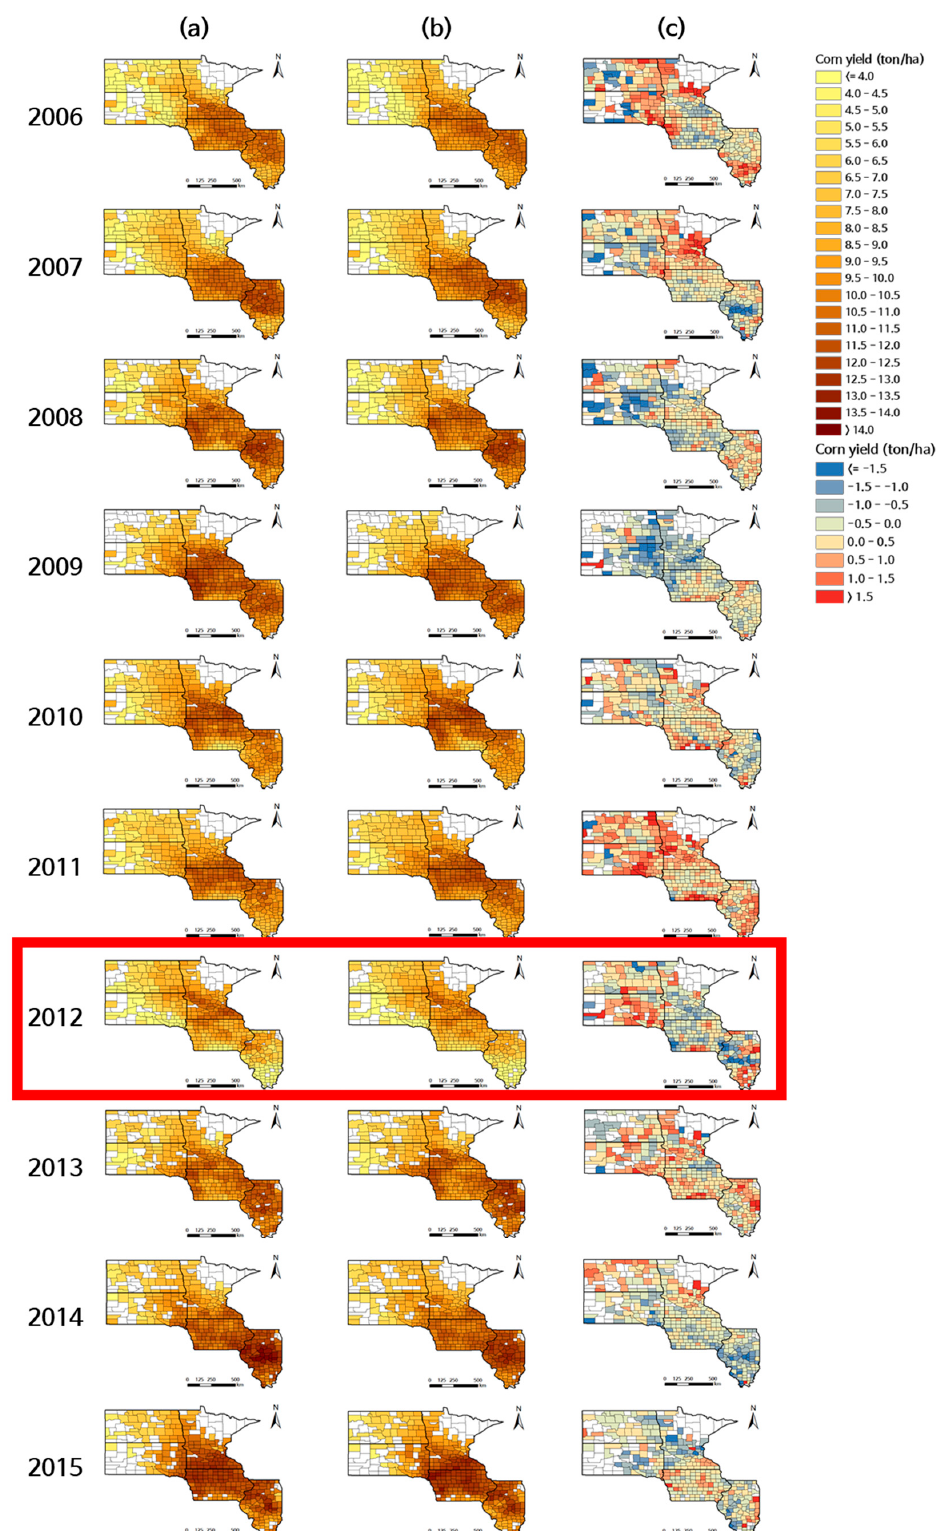
Figure 6. Maps for ( a ) actual and ( b ) predicted corn yields and the ( c ) prediction errors from the leave-one-year-out blind tests for 2006–2015. The year 2012 for a drought case showed lower corn yields than the other typical years, but the accuracy was similar to that of the other years.